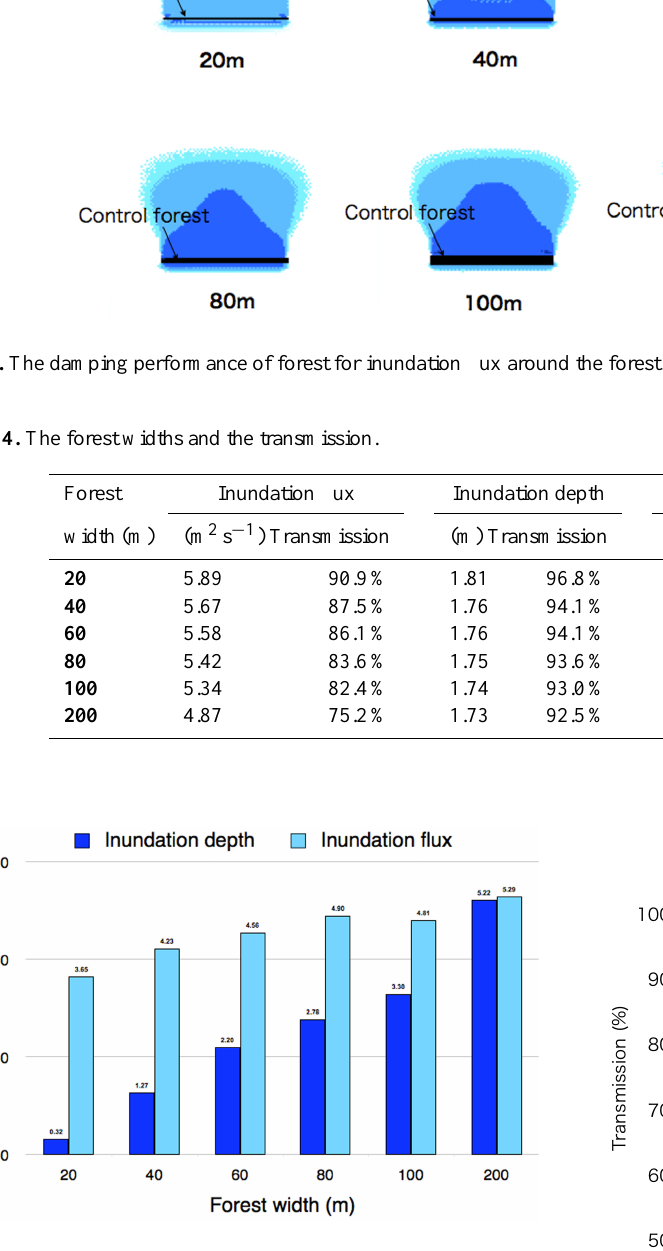
Fig. 10. The influenced area and the forest width.